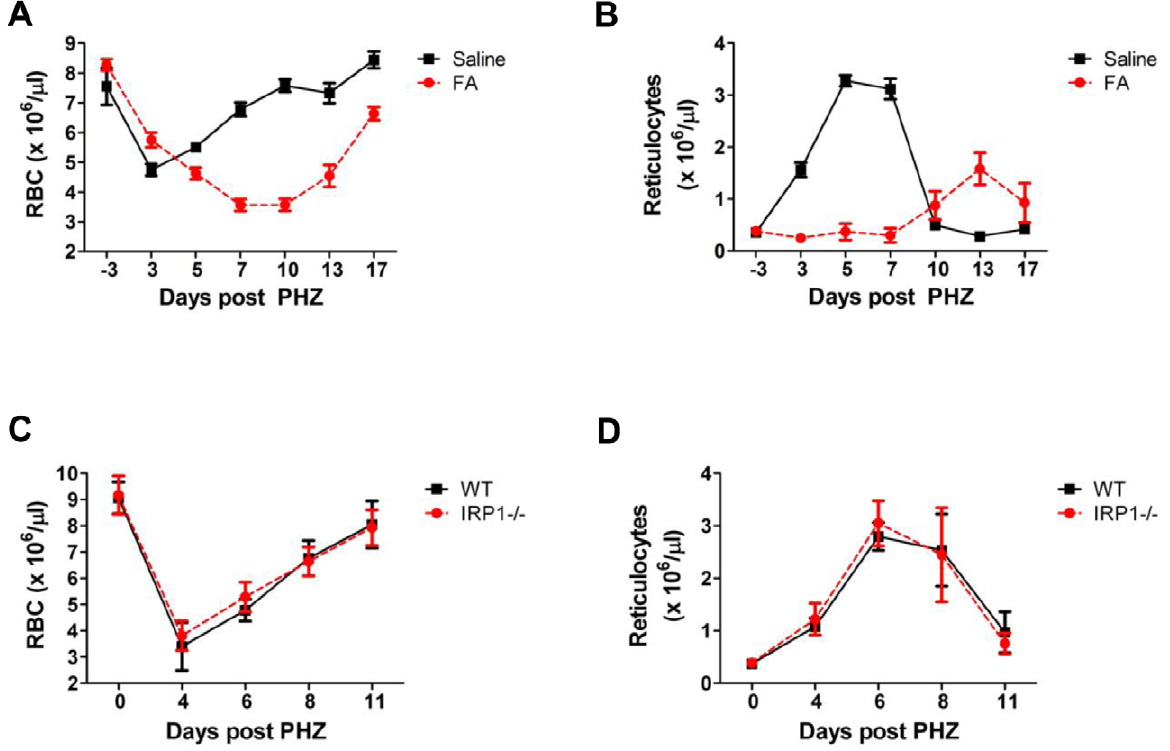
Figure 2. Inhibition of aconitase impairs responsiveness to anemic challenge. ( A ) RBC and ( B ) absolute reticulocyte counts in PHZ- challenged mice treated with either FA (4 mg/kg/day; n=11) or saline (0.9%; n=6). PHZ injections on days 0 and 1 consisted of 30 mg/kg/day for the FA group and 60 mg/kg/day for the saline group. Data represent mean 6 SD. ( C ) RBC and ( D ) absolute reticulocyte counts in IRP1 2 / 2 and wild type (WT) mice. PHZ doses for both groups consisted of 60 mg/kg/day on days 0 and 1. Data represent mean 6 SD; n=8 per group.